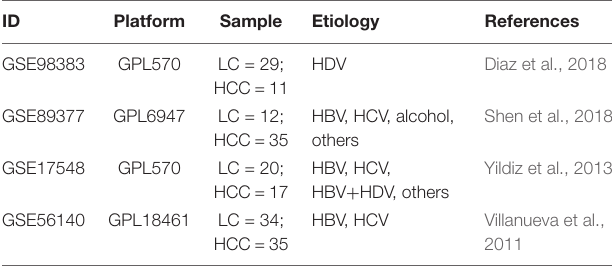
TABLE 1 | Detailed information of the four microarray datasets used in the present